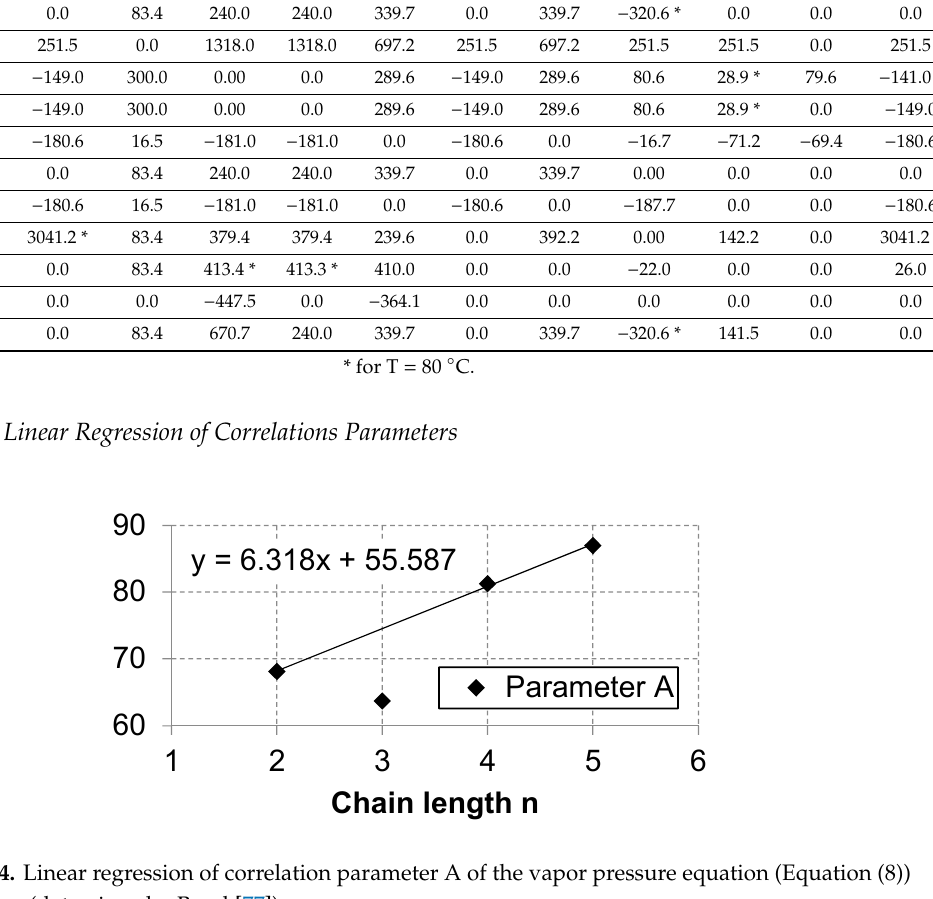
Table A4. Interaction parameters Ψ ij of the UNIFAC groups listed in Tables A2 and A3. i\j